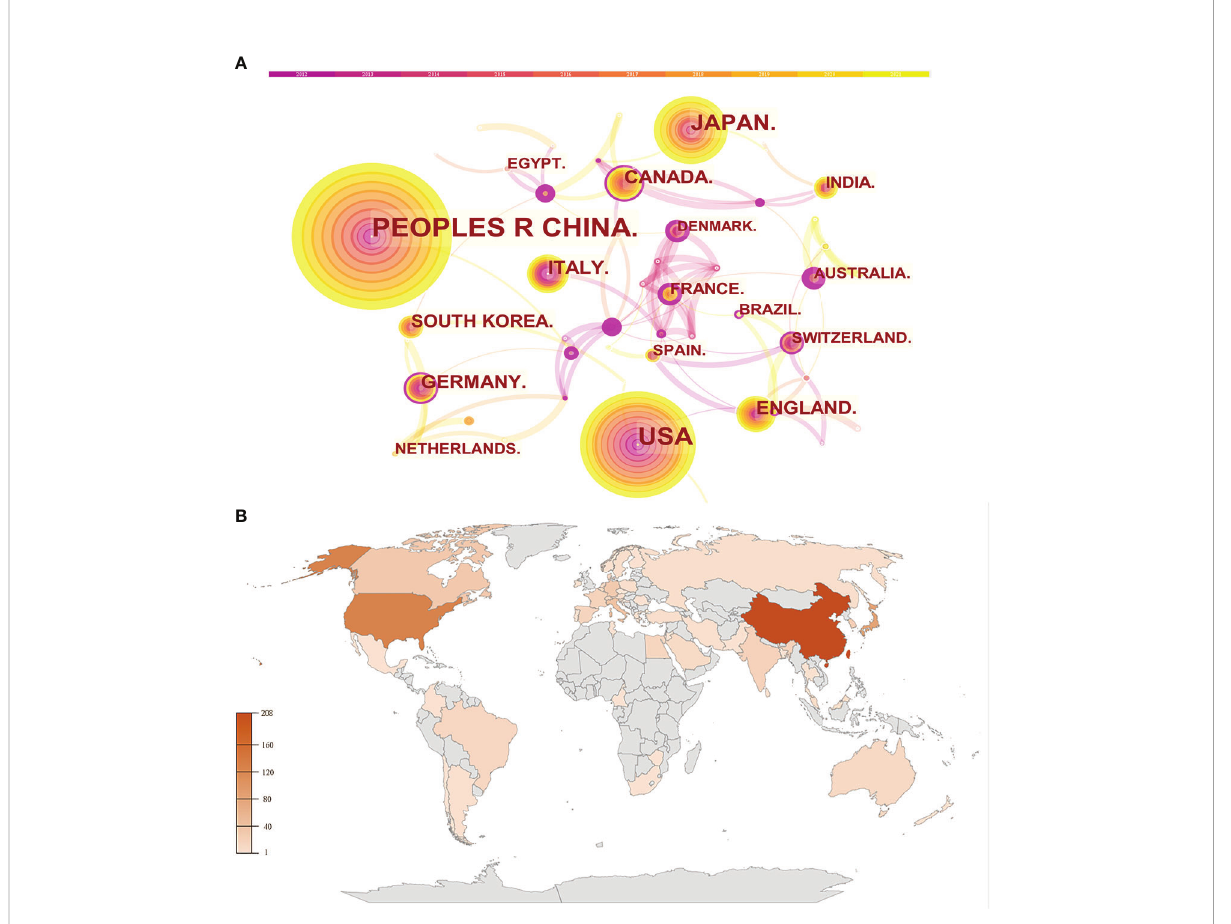
FIGURE 2 Visualization of countries. (A) Collaboration network of countries. (B) World map of publications distributed in various